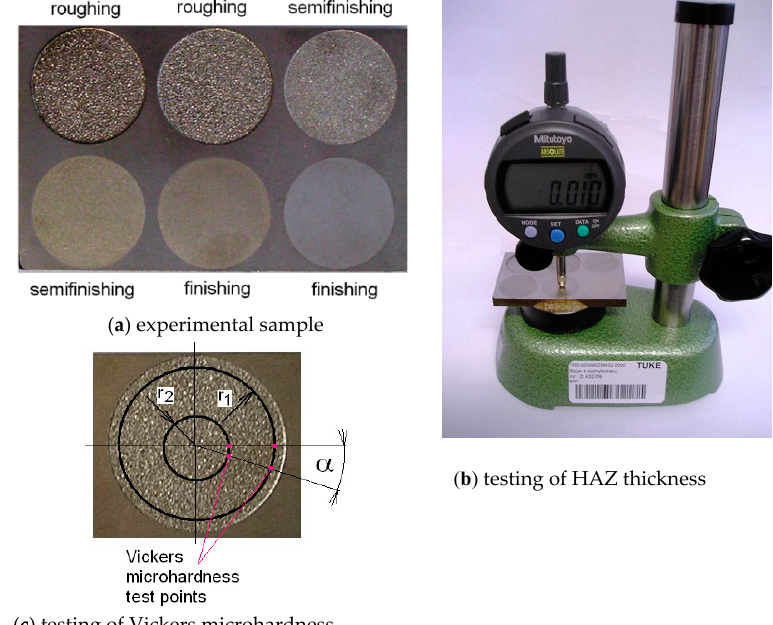
Figure 8. Testing of Vickers microhardness and measurement of total HAZ thickness on metallographic section of experimental sample from tool steel EN X32CrMoV12 ‐ 28 after die ‐ sinking EDM with a SF ‐ Cu electrode.